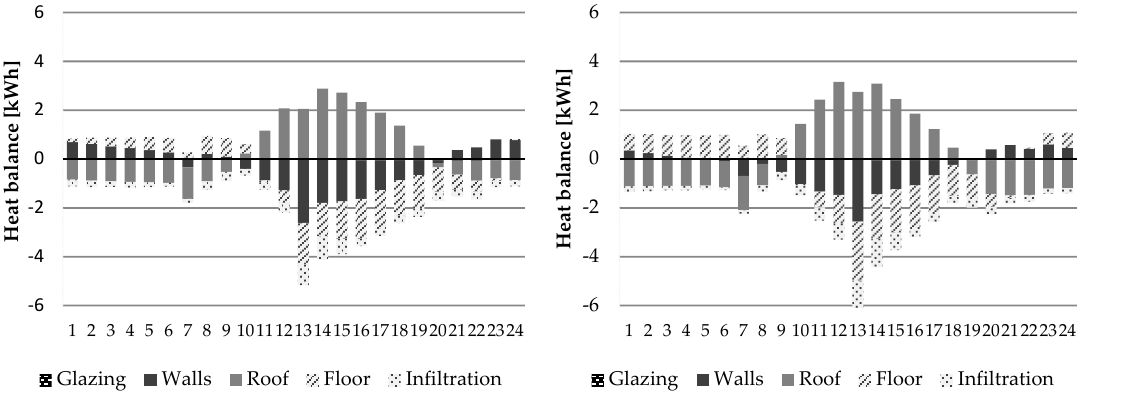
Figure 6. Dwellings envelope heat balance for a week with high DNI; ( a ) Case C—earthen envelope heat balance; and ( b ) Case D—concrete envelope heat balance.